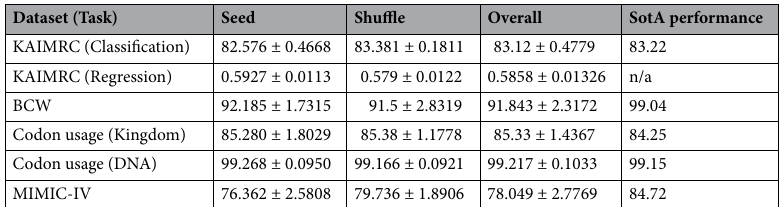
Table 2. Summary of mean accuracy/ R 2 (± standard deviation) for the baseline models when the seed and training set order is changed during training. The state of the art (SotA) model performance is also reported to confirm the models are properly trained.